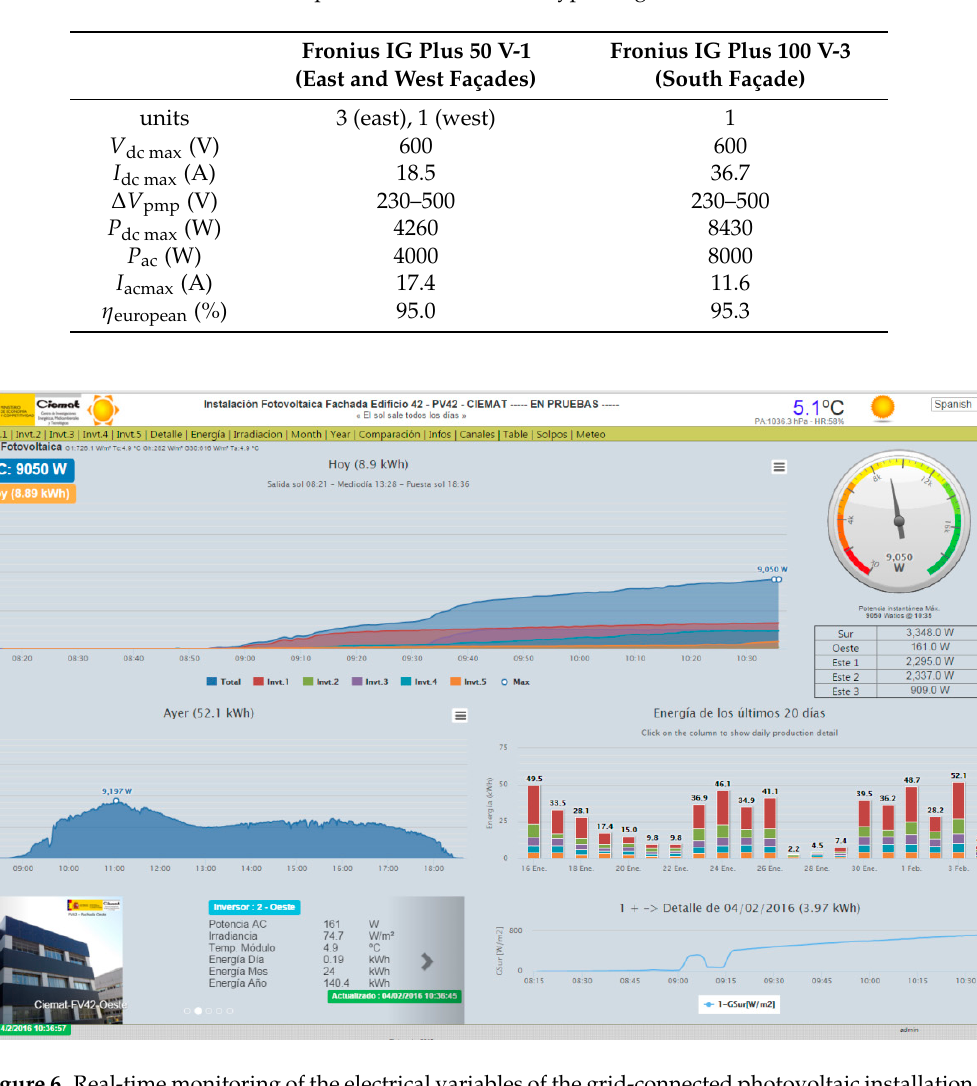
Table 2. Main electrical specifications of the two types of grid connection inverters.